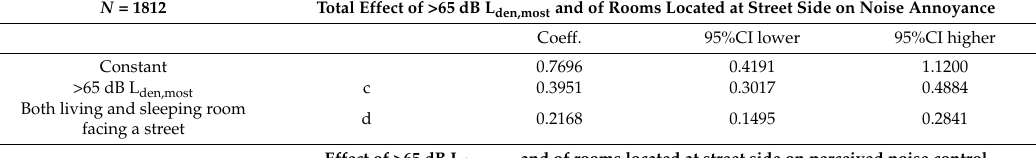
Table 4. Association of exposure to road traffic noise (>65 dB L den,most ) and absent quiet side (rooms located at street side) with perceived noise control and noise annoyance 1